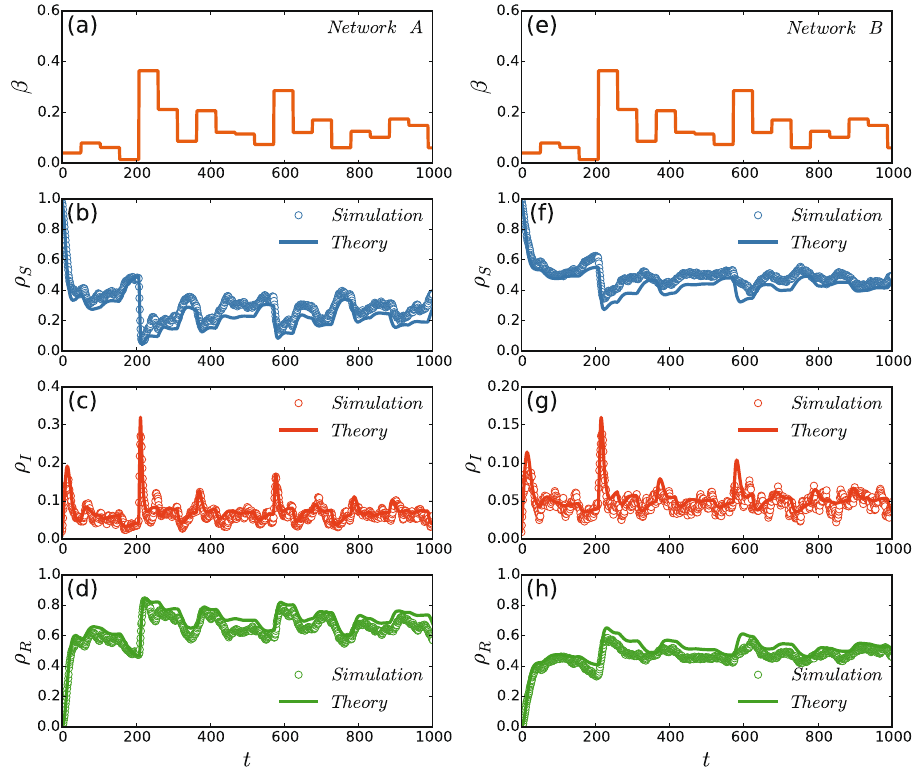
Figure 6. Comparison between the theoretical solutions and numerical simulations. The left and right panels are for the networks and A B , respectively. All the parameters are the same as in Fig. 3(a) and (b). ( a ) and ( e ) β ( t ) versus t ; ( b ) and ( f ) ρ ρ ρ S versus t ; ( c ) and ( g ) I versus t ; ( d ) and ( h ) R versus t . In ( b – d ) and ( f – h ), the solid curves represent the theoretical solutions while the “circles” represent the numerical